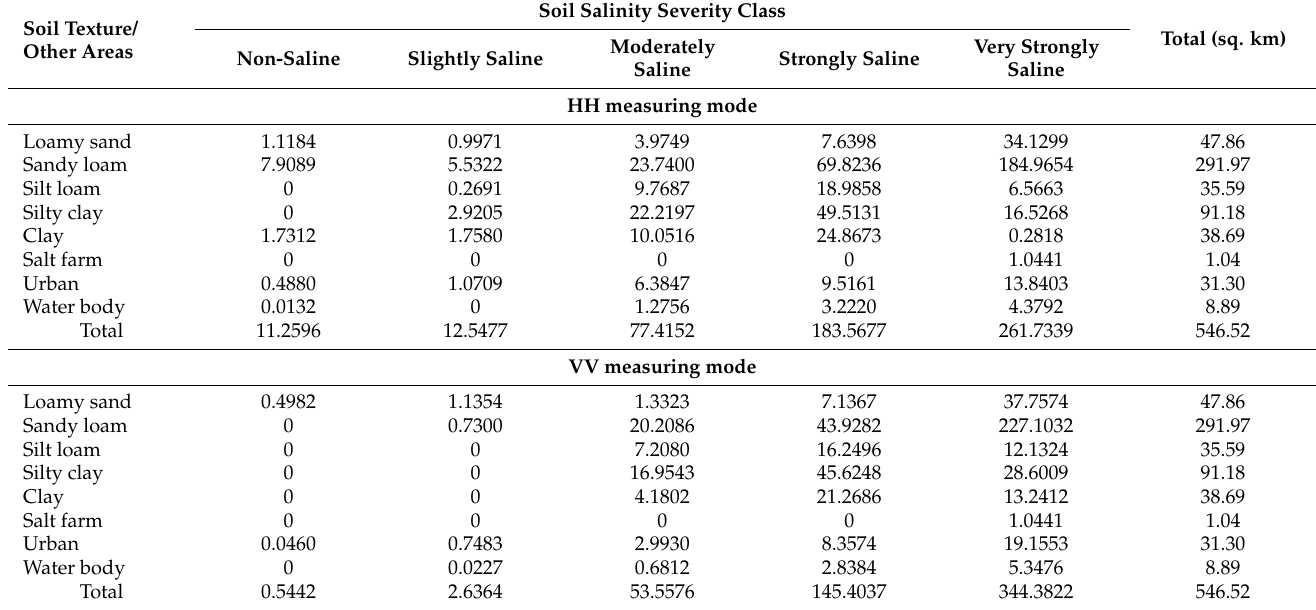
Table 20. Area of soil texture and soil salinity severity classification in the two measuring